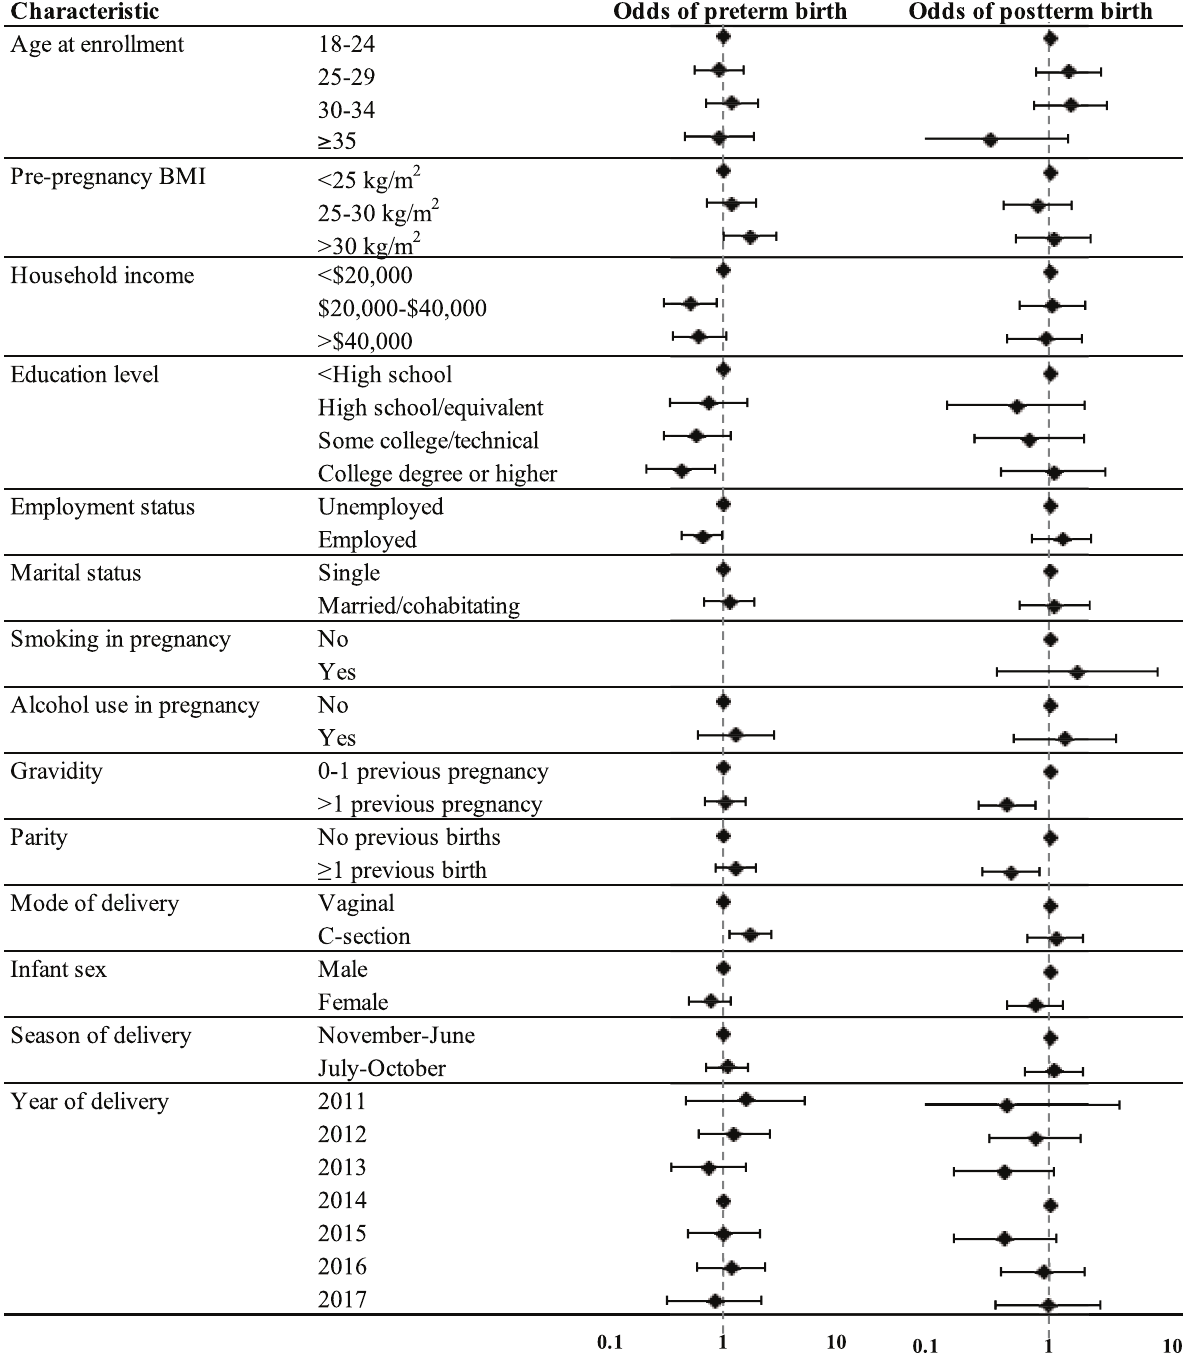
PLOS ONE | https://doi.org/10.1371/journal.pone.0217770 June 13,